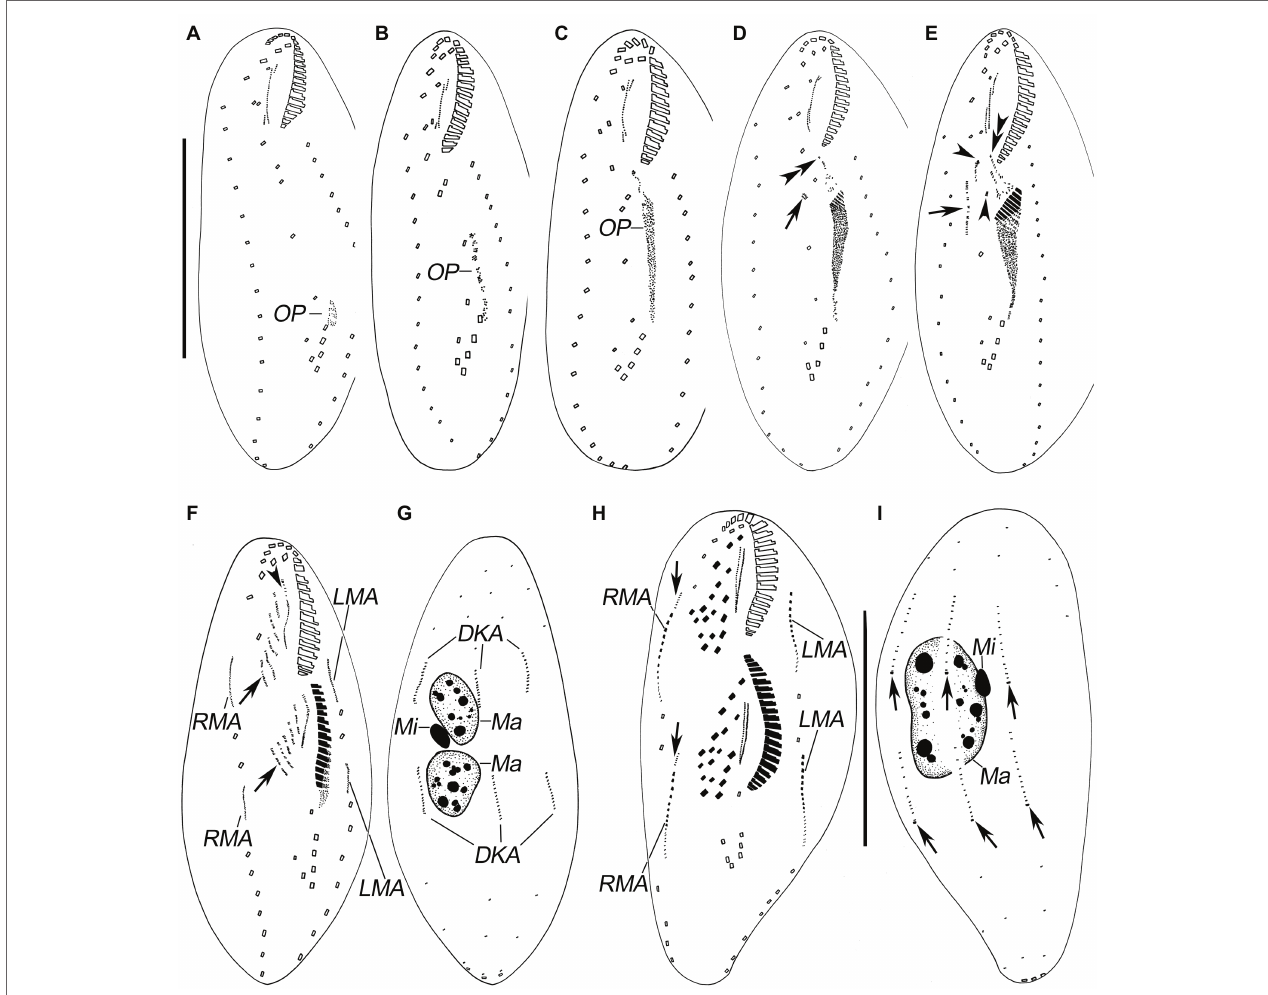
FIGURE 3 | Morphogenesis of Quadristicha subtropica n. sp. after protargol staining. (A–C) Ventral views of very early dividers showing the newly formed oral primordium. (D) Ventral view of an early divider, arrow marks the dedifferentiation of cirrus V/4, and double arrowheads indicate the UM-anlage. (E) Ventral view of a slightly later divider, arrow shows the frontal-ventral-transverse cirral anlagen, arrowheads mark the dedifferentiation of cirri IV/2 and IV/3, and double arrowheads indicate the UM-anlage. (F,G) Ventral and dorsal view of a divider, arrows show frontal-ventral-transverse cirral anlagen and arrowhead denote the frontal cirrus separated from the frontal-ventral-transverse cirral anlage I. (H,I) Ventral and dorsal view of a mid-divider, arrows in H mark the dorsomarginal kineties anlagen and arrows in I demonstrate the newly formed caudal cirri. Bars: 50 μ m (A–G) ; 60 μ m (H,I)